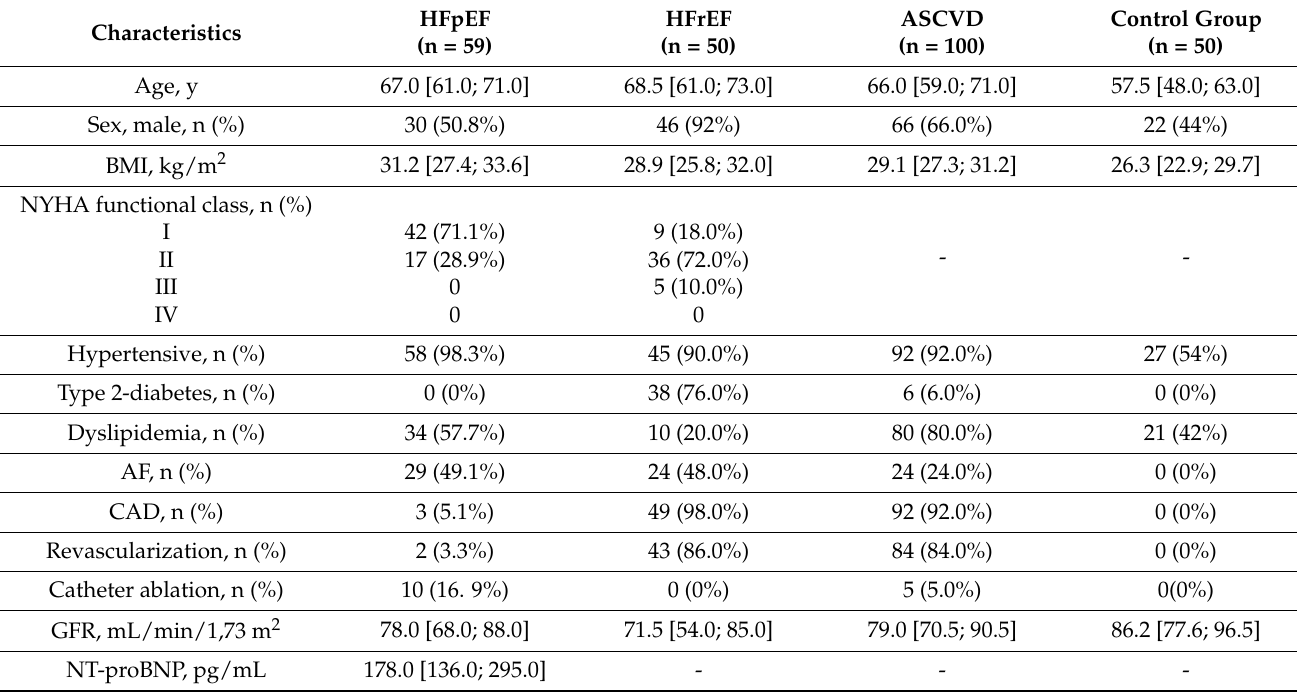
Table 1. The main characteristics of